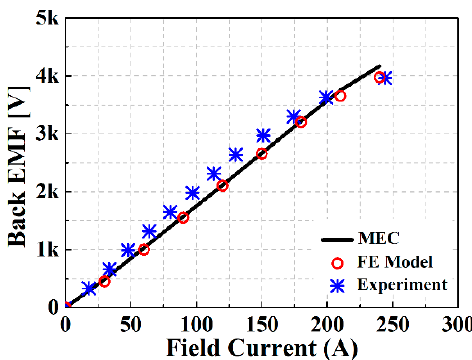
Figure 12. Comparison of back EMF values as the field current changes.